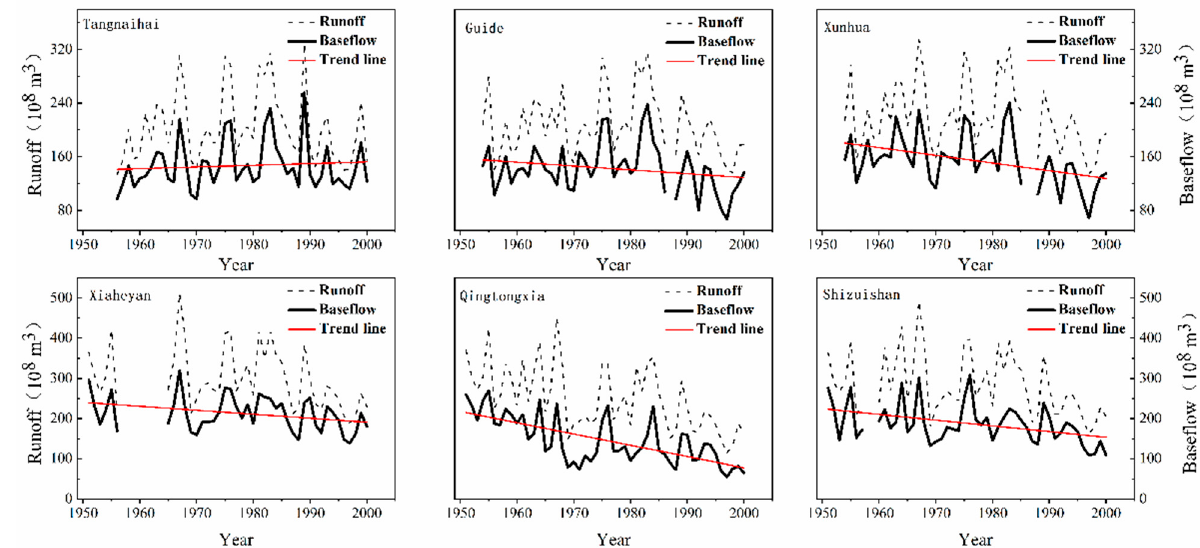
Figure 2. Interannual variation of river discharge and baseflow volume.